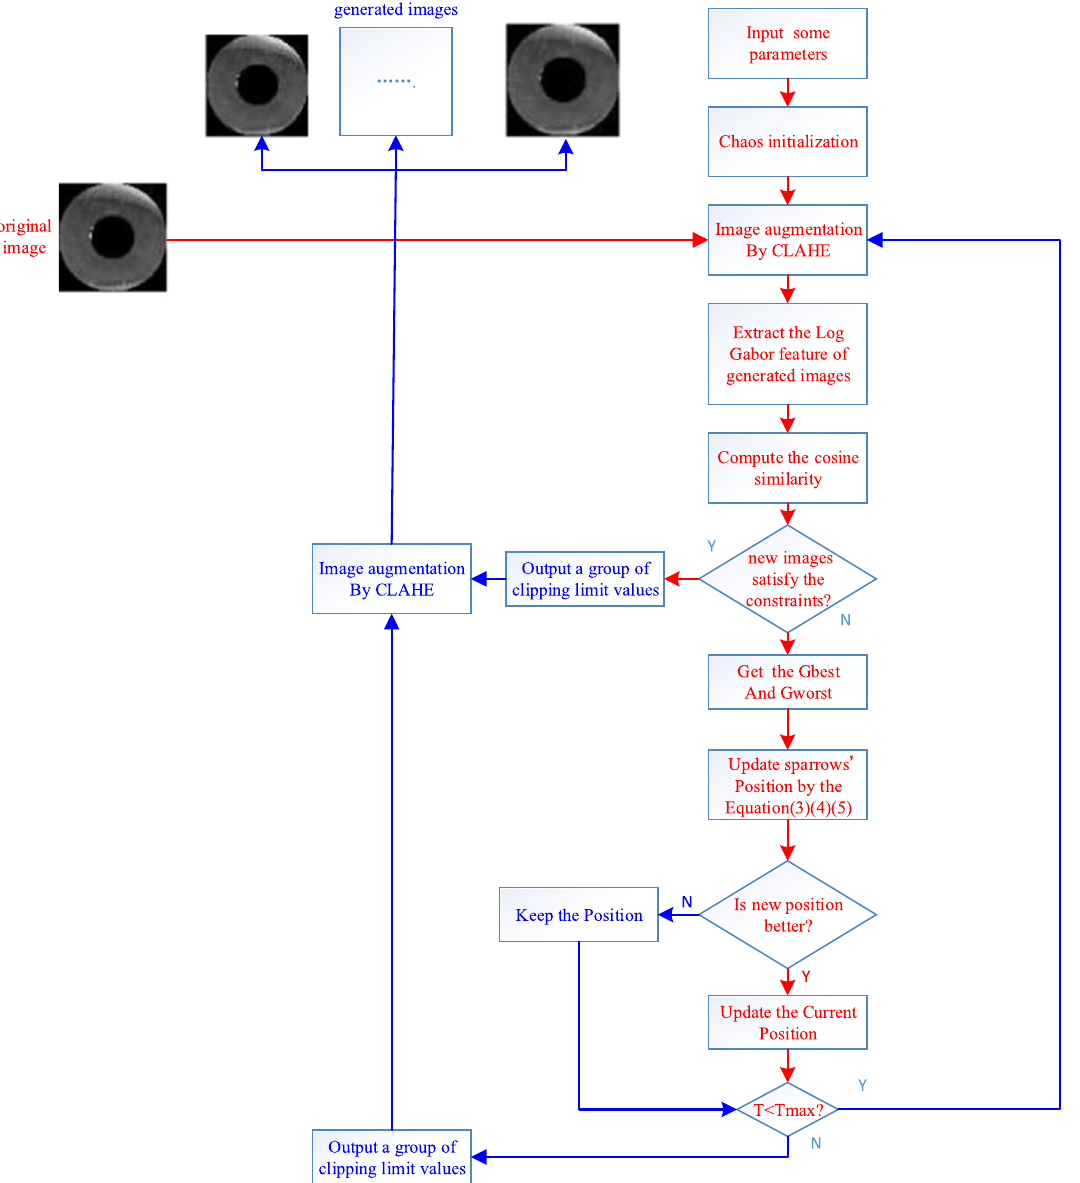
Fig. 3 Detailed flow chart of iris image